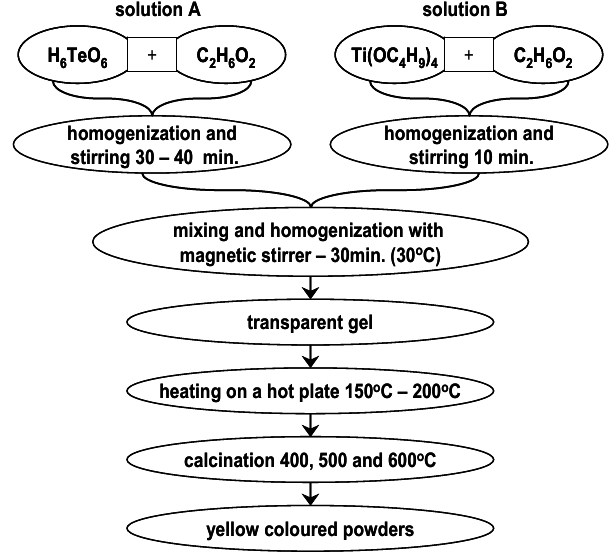
Figure 10. Temperature dependencies of the conversion during the catalytic oxidation of CO, methane over TiO 2 and TiO 2 /0.5 wt% Pd catalysts.